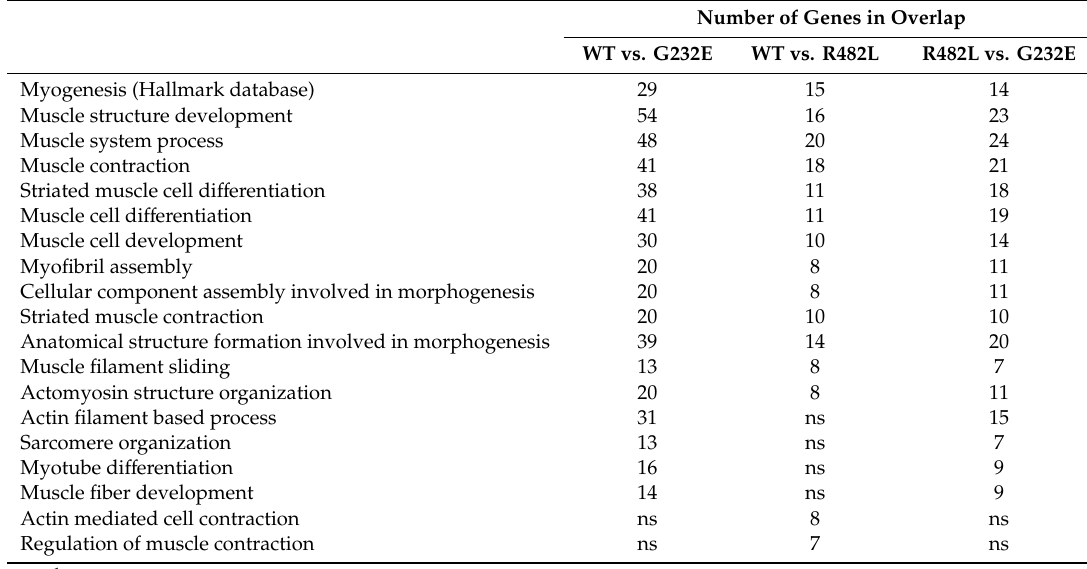
Table 3. Number of di ff erentially expressed genes (DEGs) found in both—pathways and DEGs of control transgenic samples ( p < 0.0001) 1